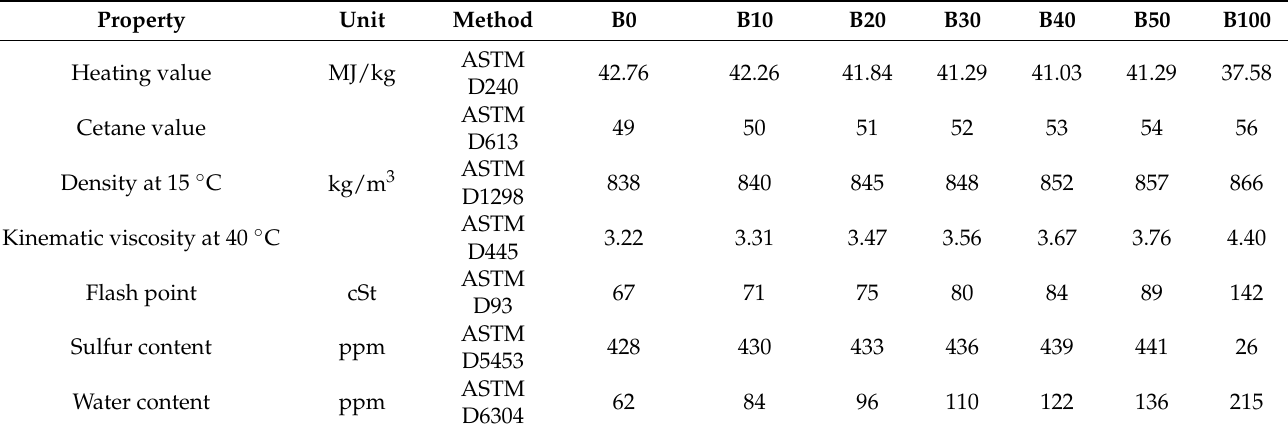
Table 3. Properties of test fuel.